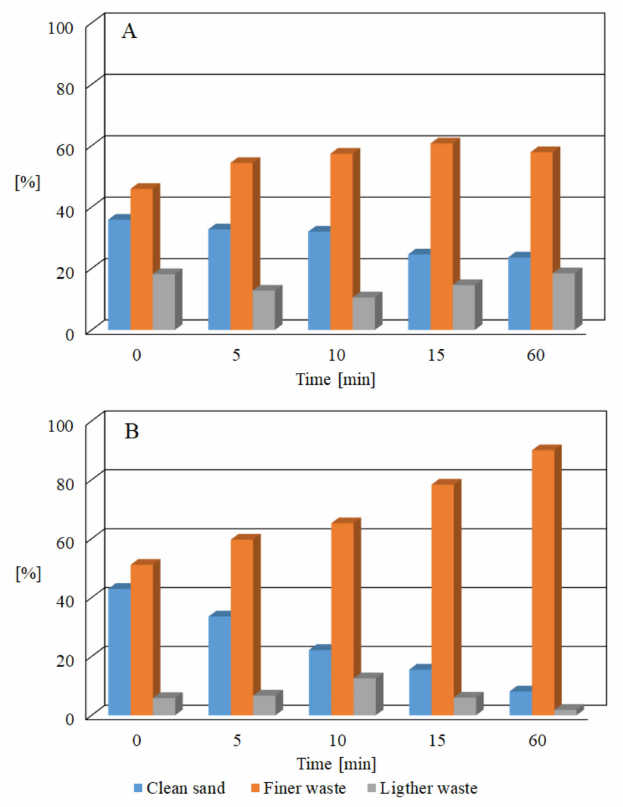
Figure 10. Contaminants distribution depending on process type. ( A ) By stirring ( B ), by light milling.